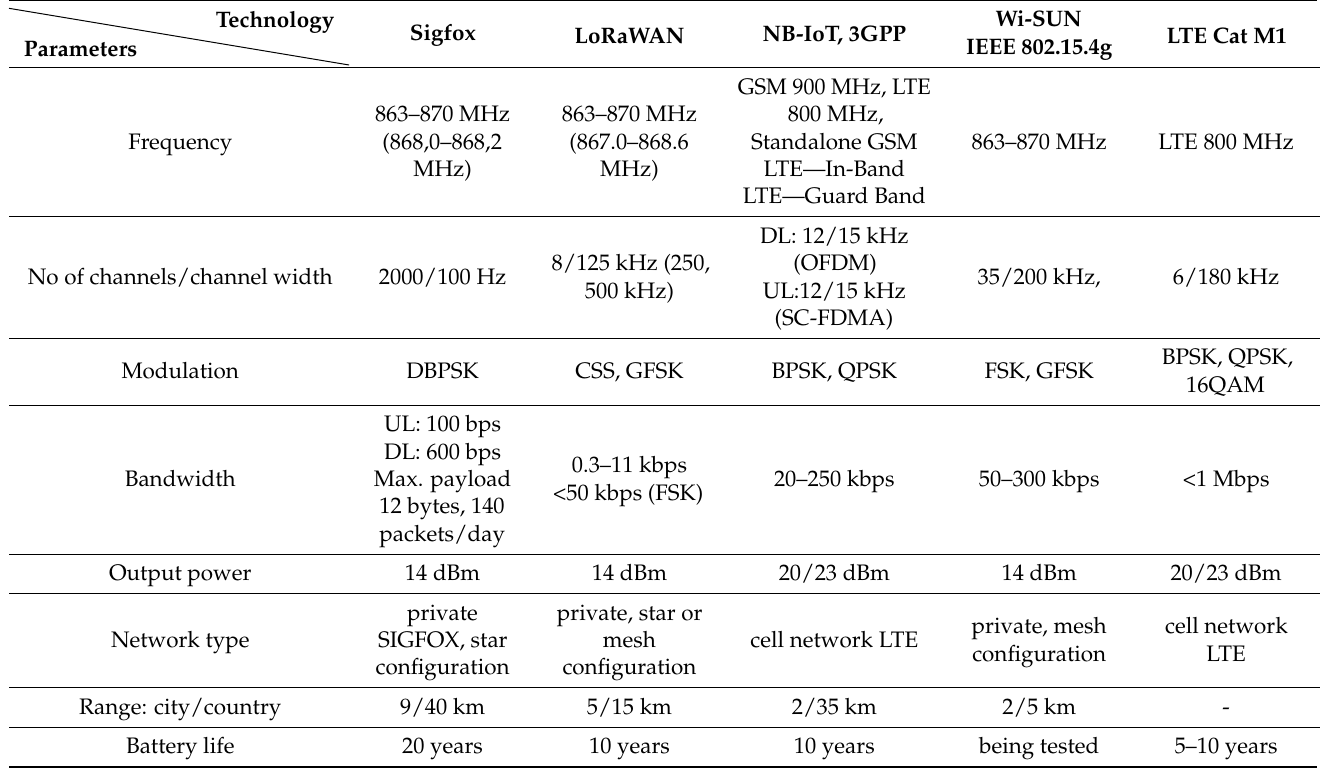
Table 1. LPWAN characteristics